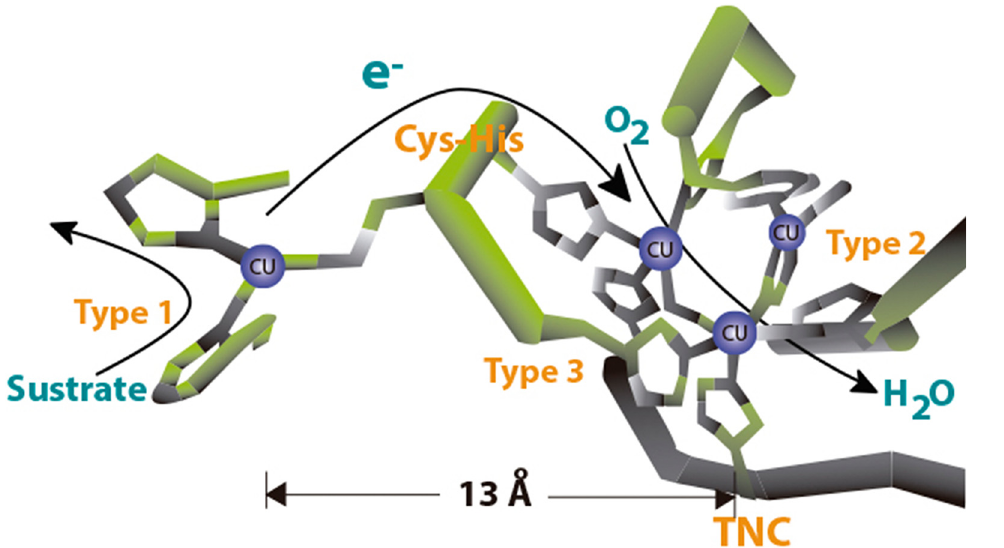
Fig 2. MCO active site with arrows marking electron flow from the T1 to the trinuclear site.